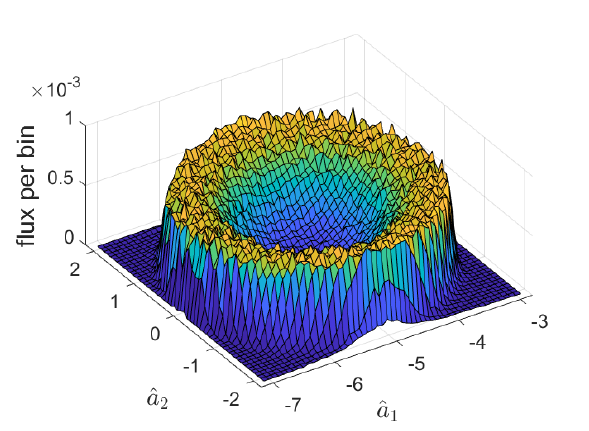
Figure 4: Raytraced resulting output illumination for the second test